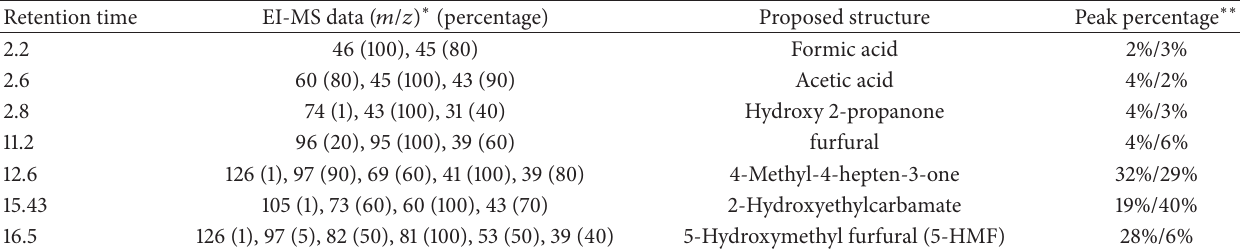
5-Hydroxymethyl furfural (5-HMF)